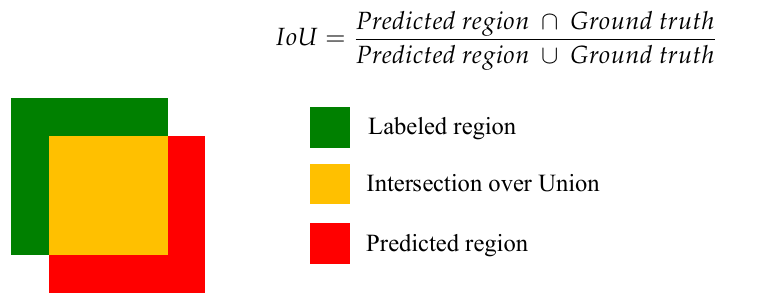
Figure 8. Schematic diagram of the predicted and labeled regions.